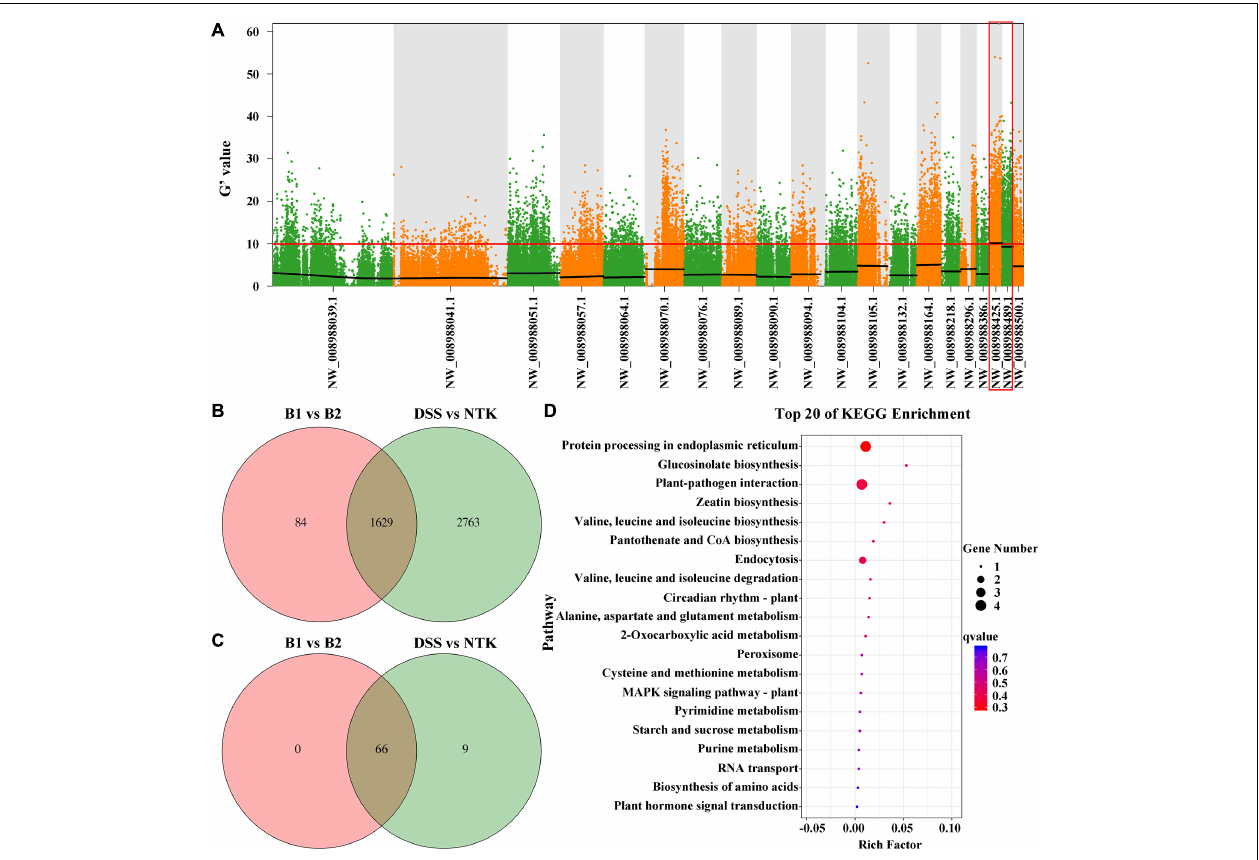
FIGURE 2 | Russet skin trait locus and variant genes identified by bulked segregant analysis combined with the genome sequencing analysis. (A) Using the G’ algorithm to map the PpRus gene locus. The distribution of G’ values on the chromosome is shown. The abscissa gives the chromosome scaffold names. The colored dots represent the G’ values at each single nucleotide polymorphism locus. The red line represents the threshold of significant association. The higher the G’ value, the better is the correlation. (B) Venn diagram showing the intersection of all variant genes identified in pairwise analyses (B1 vs. B2 and DSS vs. NTK). DSS: ‘Dangshansu’ (non-russet skin pear cultivar); NTK: ‘Niitaka’ (russet skin pear cultivar); B1: non-russet skin fruit bulk; B2: russet skin fruit bulk. (C) Venn diagram representation of variant genes from a pairwise comparison of the two scaffolds NW_008988425.1 and NW_008988489.1. (D) KEGG pathway enrichment analysis of variant genes in the scaffolds NW_008988425.1 and NW_008988489.1.